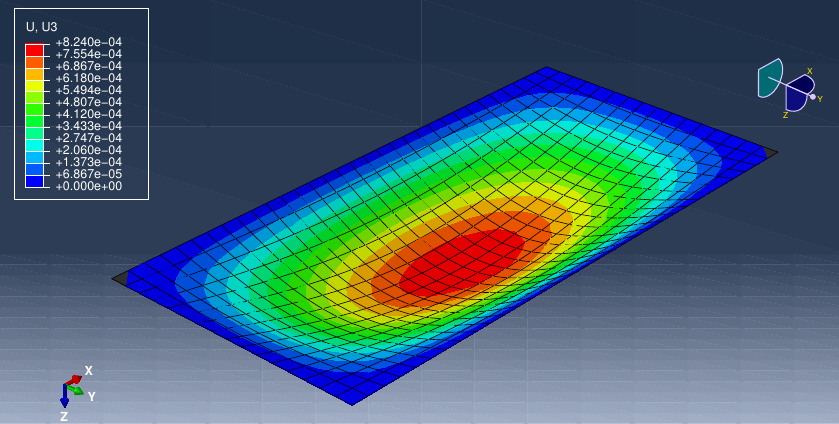
Figure A4. The deflection of a simply supported rectangular plate solved using